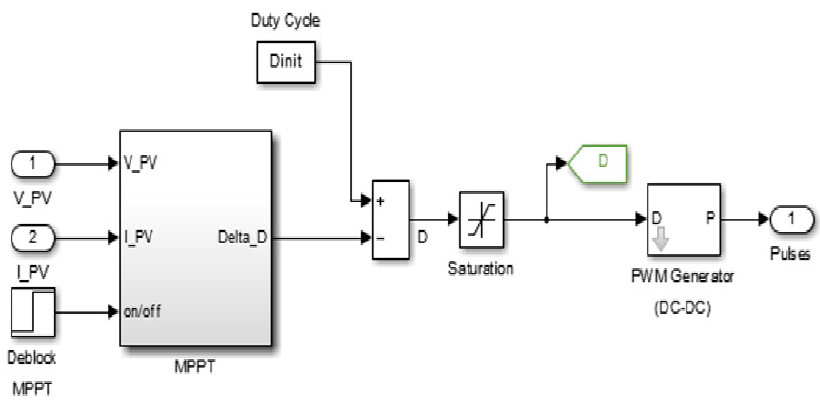
Figure 10. MPPT control block.